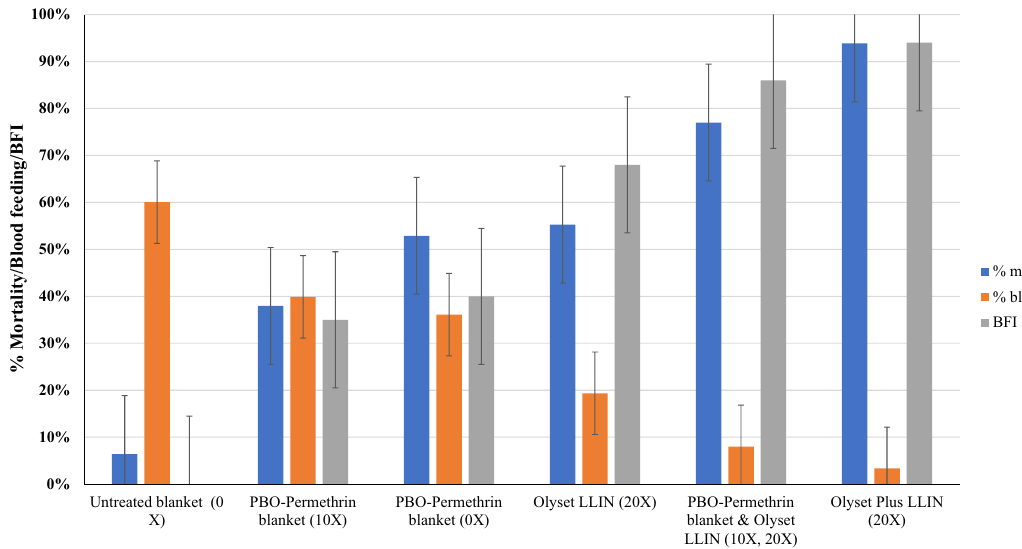
Figure 6. Mortality and blood feeding rates for different treatment arms. Error bars are equivalent to 95% confidence intervals.